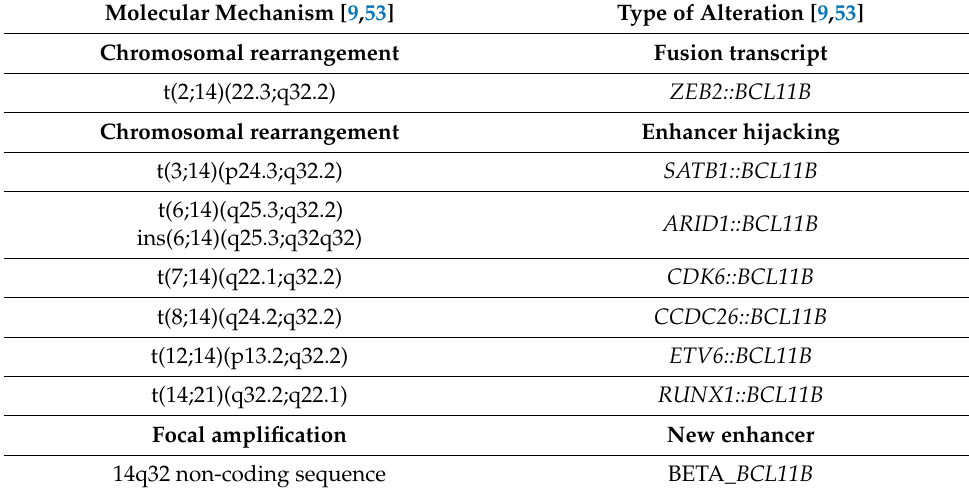
Table 4. Genomic rearrangements underlying BCL11B